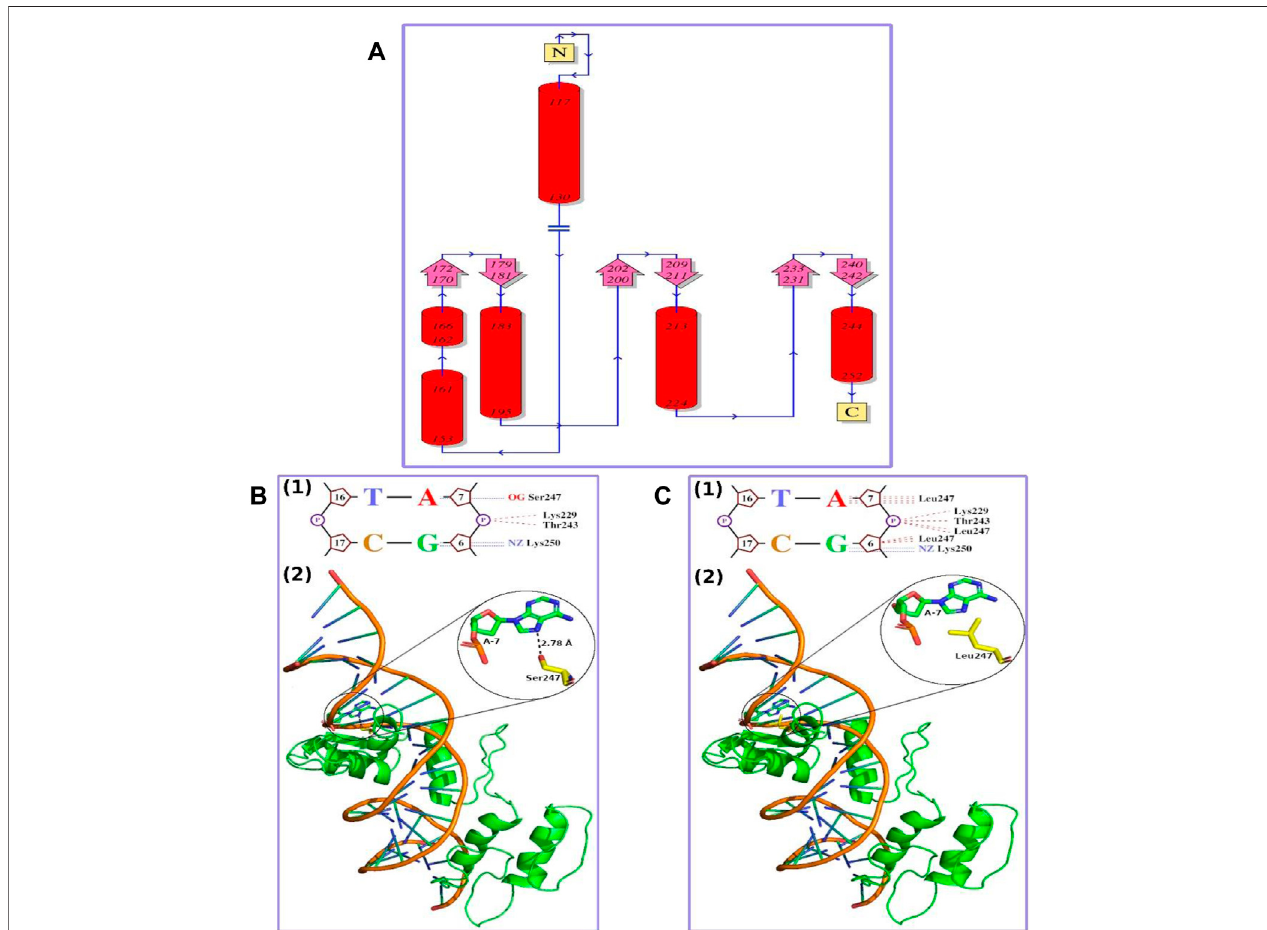
FIGURE 2 | (A) Topology diagram of GLI1 protein. N and C show N- and C-terminal of the protein, respectively. Red cylinders marked with initial and fi nal amino acid positions show alpha helices. Pink arrows show beta strands, and blue lines marked with direction (N-terminal to C-terminal) show loops or random coils. The mutation observed in this study (S247L) falls in C-terminal helix (B) Wild-type GLI1 protein in complex with native DNA. (1) Small part of DNA – protein interaction plot showing a hydrogen bond as blue dashed lines and non-bonding interactions as red dashed lines. “ A, ” “ T, ” “ G, ” and “ C ” represent nitrogenous bases; fi ve- membered ring structure represents sugar; and “ P ” in circle represents phosphate group. Ser247 makes a hydrogen bond with nitrogenous base Adenine, A-7. (2) RibbonrepresentationoftheproteinandDNAcomplex.GLI1proteinisshowningreencolor,DNAphosphatebackboneinorangecolor,andnitrogenousbaseslikerods in green color with blue ends. Ser247 residue in yellow forming a hydrogen bond with Adenine, A-7, in green is shown in sticks with heteroatoms colored differently (O-atoms,red;andN-atoms,blue).Close-upofthehydrogenbondinteractionisprovidedintheinset (C) TheS247LmutantGLI1proteinincomplexwithnativeDNA. (1) Small part of DNA – protein interaction plot showing a hydrogen bond as blue dashed lines and non-bonding interactions as red dashed lines. The “ A, ” “ T, ” “ G, ” and “ C ” representnitrogenousbases; fi ve-memberedringstructurerepresentssugar;and “ P ” incirclerepresentsphosphategroup. (2) Ribbonrepresentationoftheproteinand DNA complex. GLI1 protein is shown in green color, DNA phosphate backbone in orange color, and nitrogenous bases like rods in green color with blue ends. Leu247 residue in yellow forming non-bonding interaction with Adenine, A-7, in green is shown in sticks with heteroatoms colored differently (O-atoms, red; and N-atoms, blue). Close-up of Leu247 and Adenine A-7 is provided in the